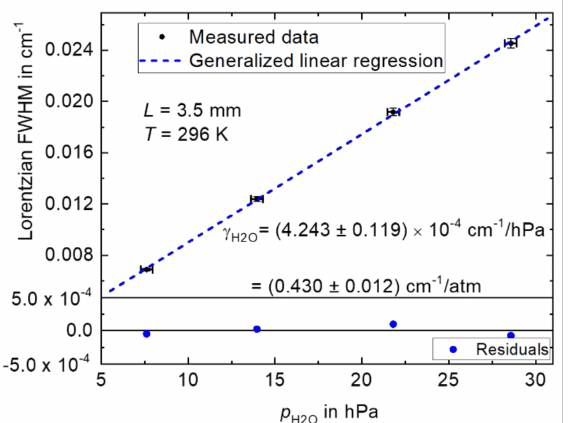
Figure 3. Measured Lorentzian FWHM of H 2 O versus measured water vapor pressure ( p H2O ). A generalized linear regression (GLR, solid blue line) was applied to the data. The bottom panel depicts the residuals from the GLR fit.